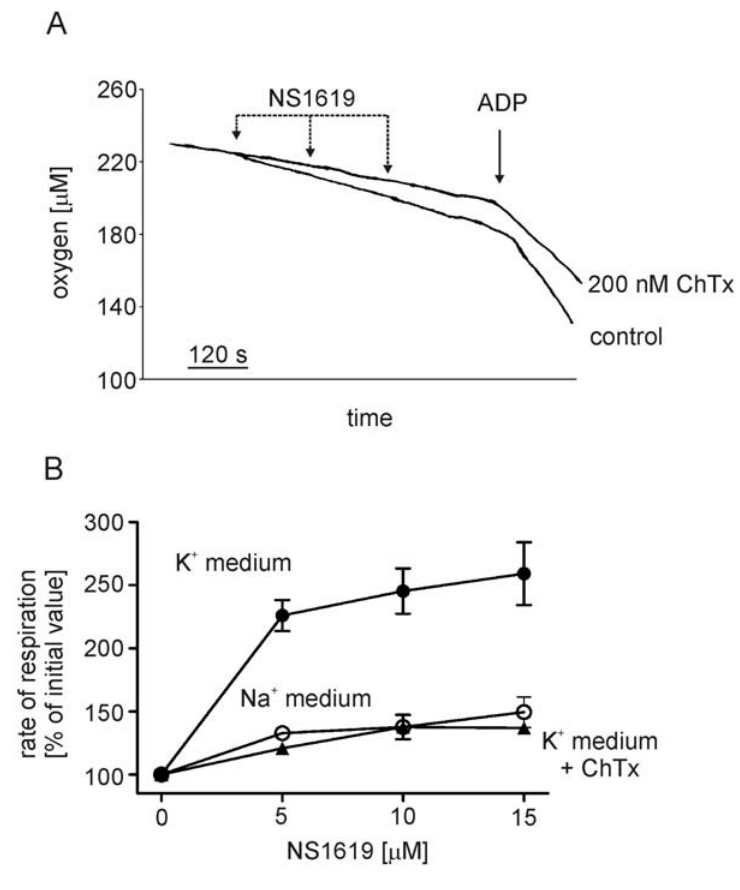
Figure 2. Potassium channel opener NS1619 induces charybdotoxin sensitive increase of rat brain mitochondria